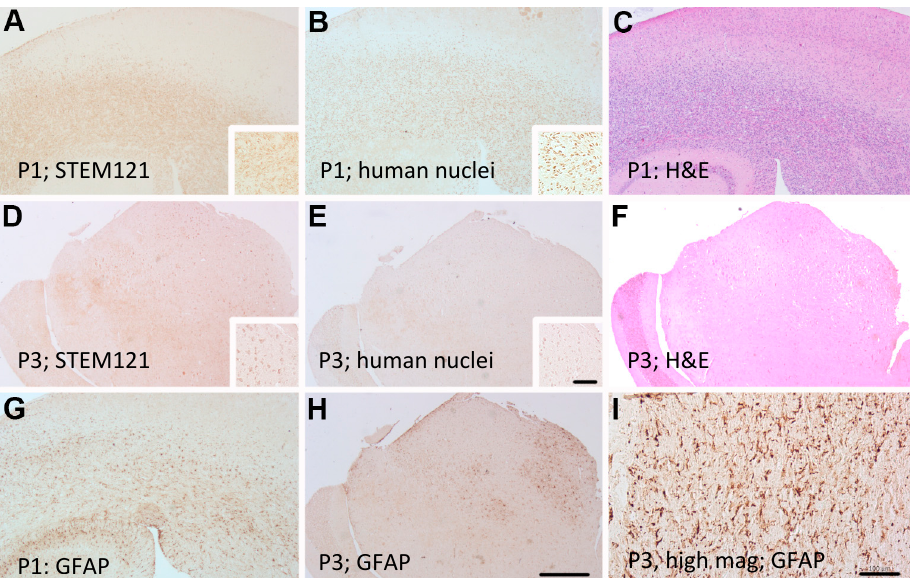
Figure 6. Adjacent sections of patient derived PDX model of case 2025 showing di ff use STEM 121 staining in passages 1 (P1) and 3 (P3) ( A , D ) respectively and di ff use human nuclei staining in passage 1 (P1) and 3 (P3) ( B , E ) respectively. GFAP staining showed reactive astrogliosis ( G , H ). Resected human tumor sample from the patient illustrates reactive gliosis (I). H&E staining clearly shows the increase tumor cell proliferation ( C , F ). Insets show individual cellular staining. Scale bar = 500 µ m ( A – H ). Scale bar = 100 µ m ( I ) Inset scale bar = 100 µ m.